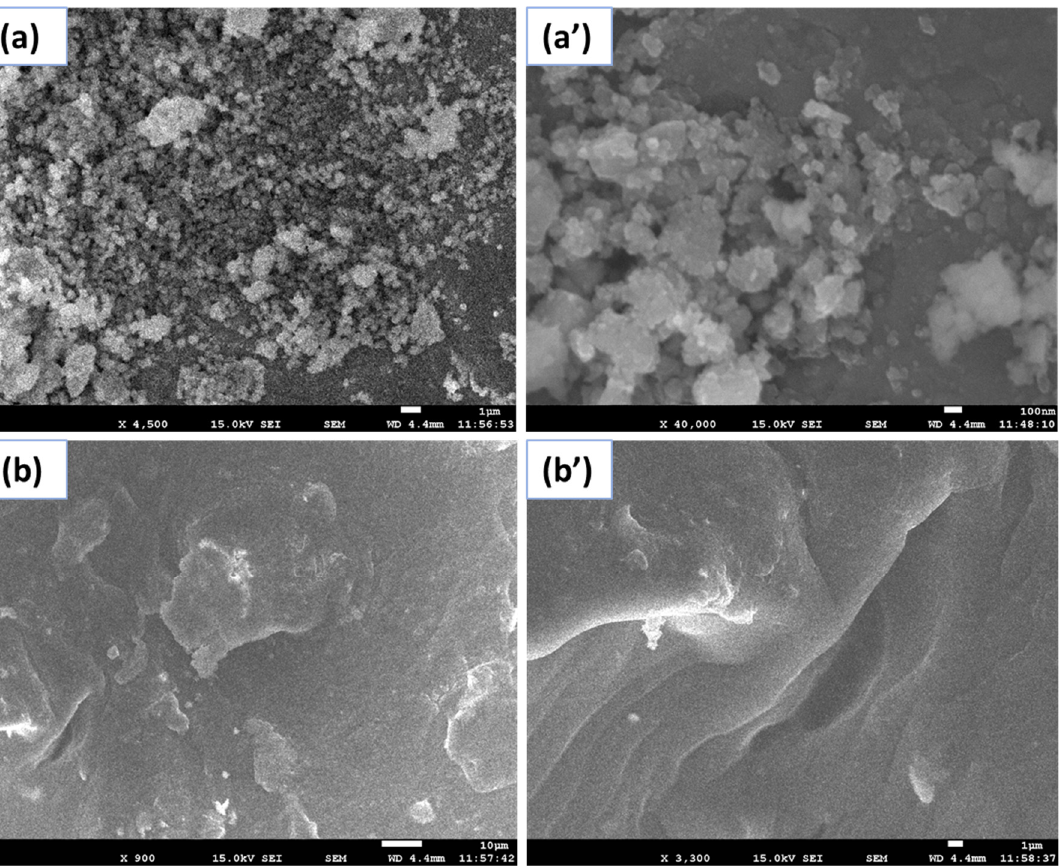
Figure 1. FESEM images of pure Co-SnO 2 nanomaterial ( a ) and GL/Co-SnO 2 nanocomposite mate- rial ( b ) of low and high magnification images ( a’ , b’ ), respectively. ( b ) of low and high magnification images ( a’ , b’ ),